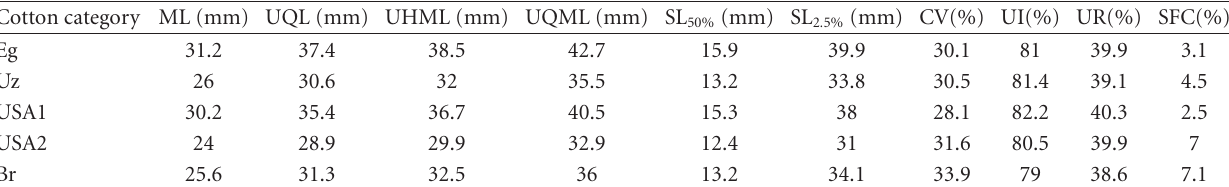
Table 1: Length characteristics of